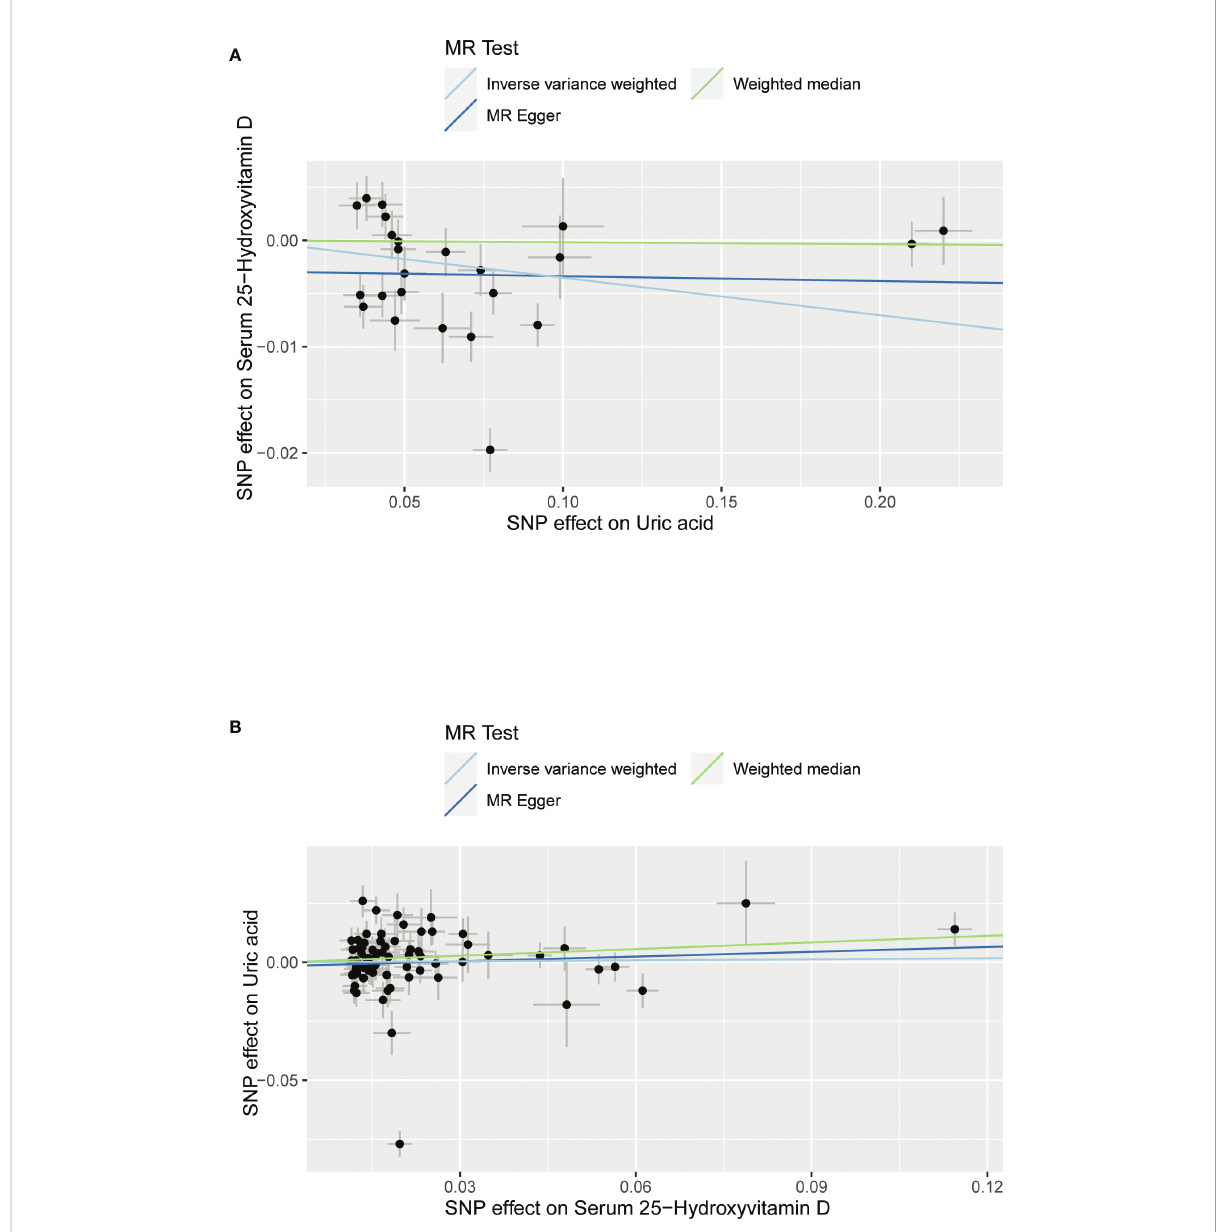
FIGURE 3 Scatter plot showing the associations of the SNP effects between serum uric acid and 25-hydroxyvitamin D. Circles indicate genetic associations between serum uric acid and 25-hydroxyvitamin D. Error bars indicate 95% con fi dence intervals. (A) Serum uric acid on 25-hydroxyvitamin D; (B) 25-hydroxyvitamin D on serum uric acid. MR, Mendelian Randomization; SNP, single-nucleotide